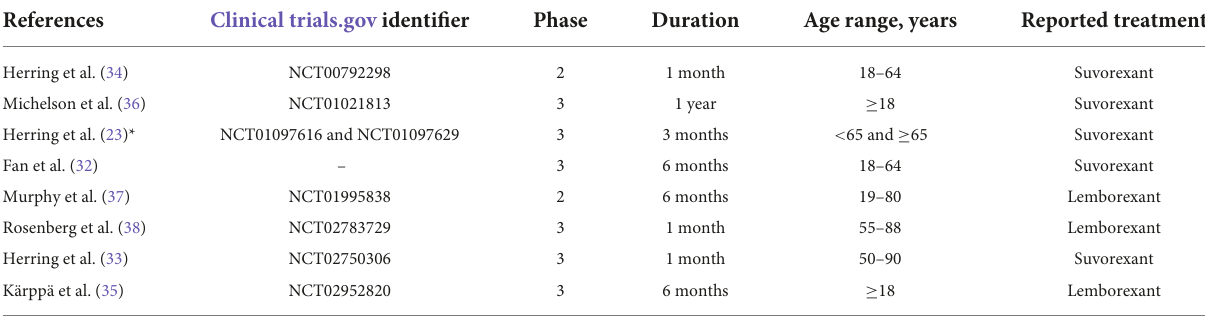
TABLE 1 Characteristics of articles included in the